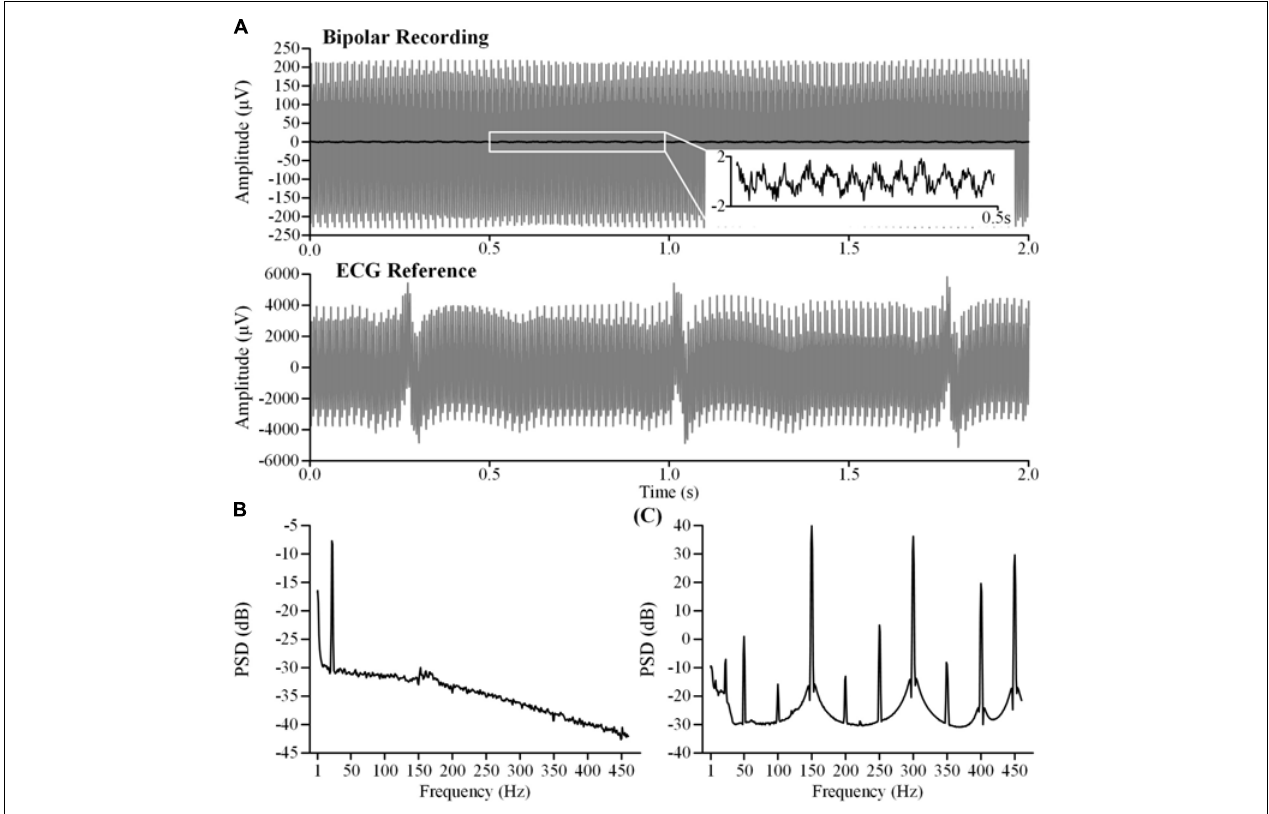
FIGURE 4 | Characteristics of the original recordings. (A) The top axis is the bipolar recording of the clean LFP (dark line) and the contaminated LFP (gray line). The bottom axis is the monopolar recording of theECG reference. The contaminated LFP and the ECG reference were synchronously recorded during stimulation (2.5 V, 150 Hz, 60 µ s). (B) The PSD of the clean LFP. (C) The PSD of the contaminated LFP.